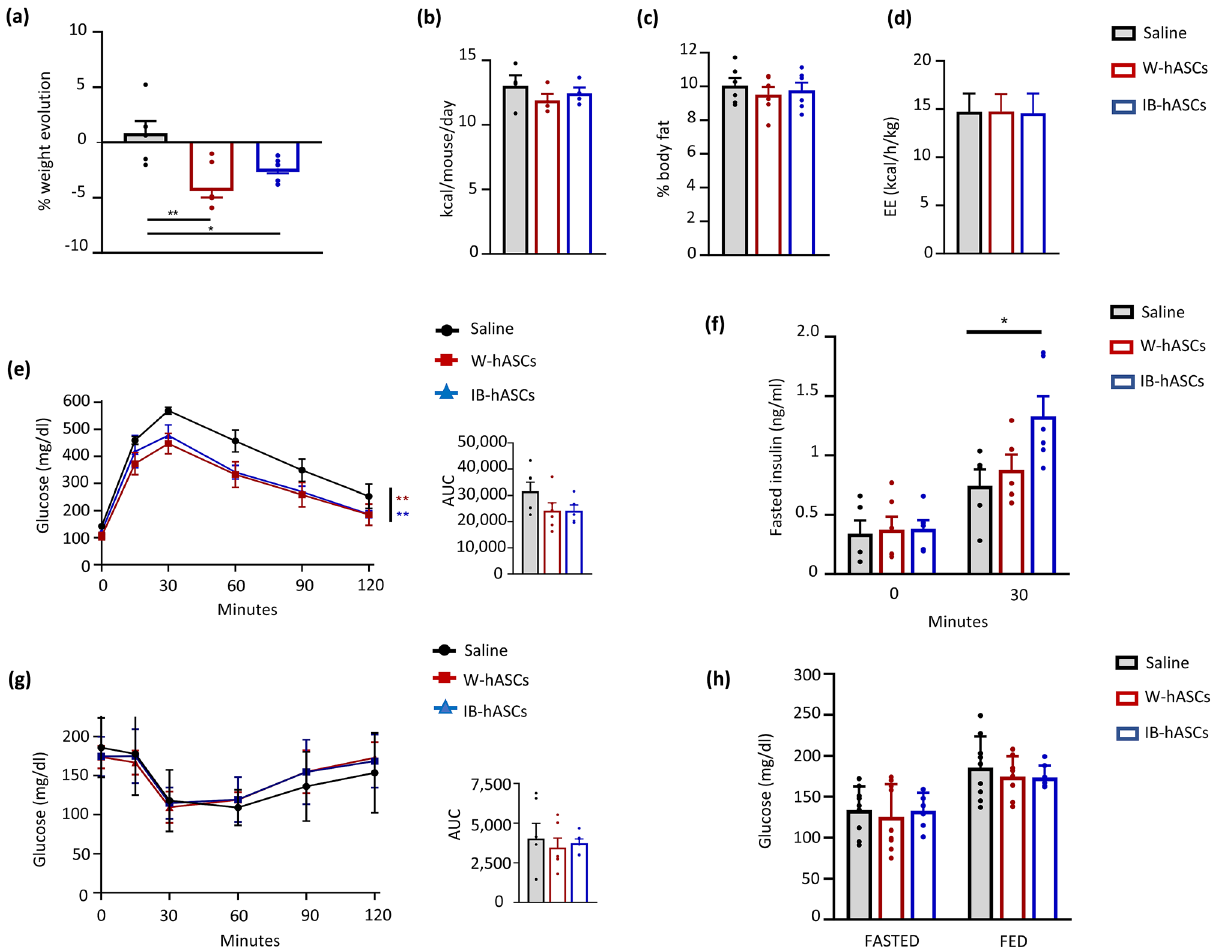
Figure 2. Infusion of IB-hASCs suppresses body-weight gain and improves glucose tolerance in DIO mice. ( a ) Body-weight progression and ( b ) food intake of high-fat diet-treated mice infused with W-hASCs, IB-hASCs or saline (n = 6). ( c ) Percentage of body fat content. ( d ) Energy expenditure. ( e ) Glucose tolerance test (n = 6) and area under the curve (AUC) analysis. ( f ) Insulin tolerance test (n = 5–6) and AUC analysis. ( h ) Fed and fasted plasma glucose levels. Results are expressed as mean ± s.e.m. * P < 0.05, ** P < 0.01 (two-way ANOVA; one-way